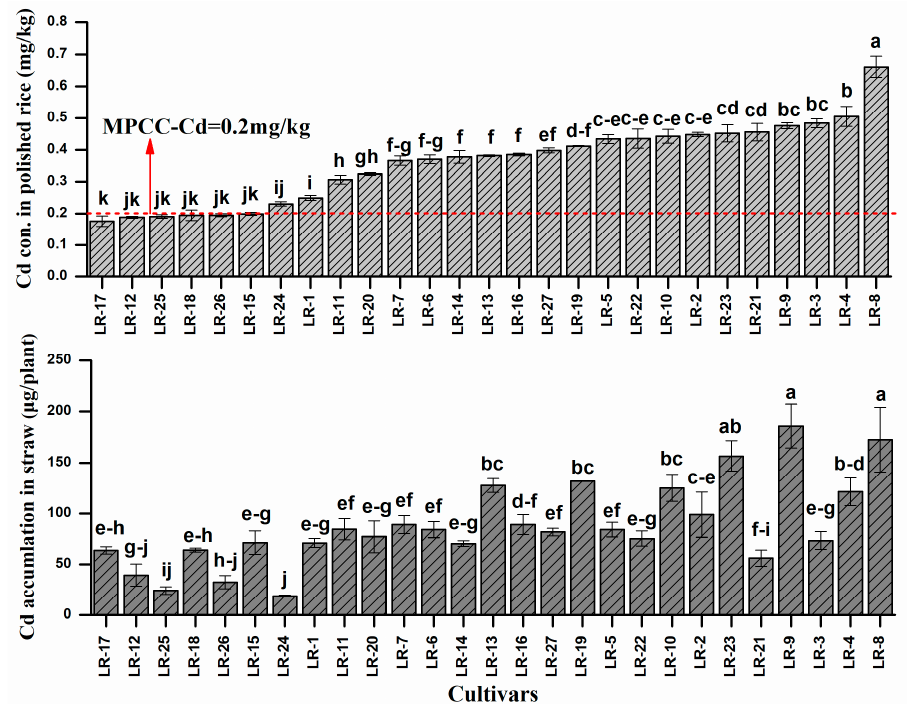
Figure 3. Cadmium concentration in polished rice grain and accumulation in straw of 27 late rice genotypes grown on Cd contaminated soil. Presented data are means of three replicates: error bars represent standard error. Different letters at the top of bars represent significant difference at p < 0.05. MPCC denotes Maximum permissible concentration in China.